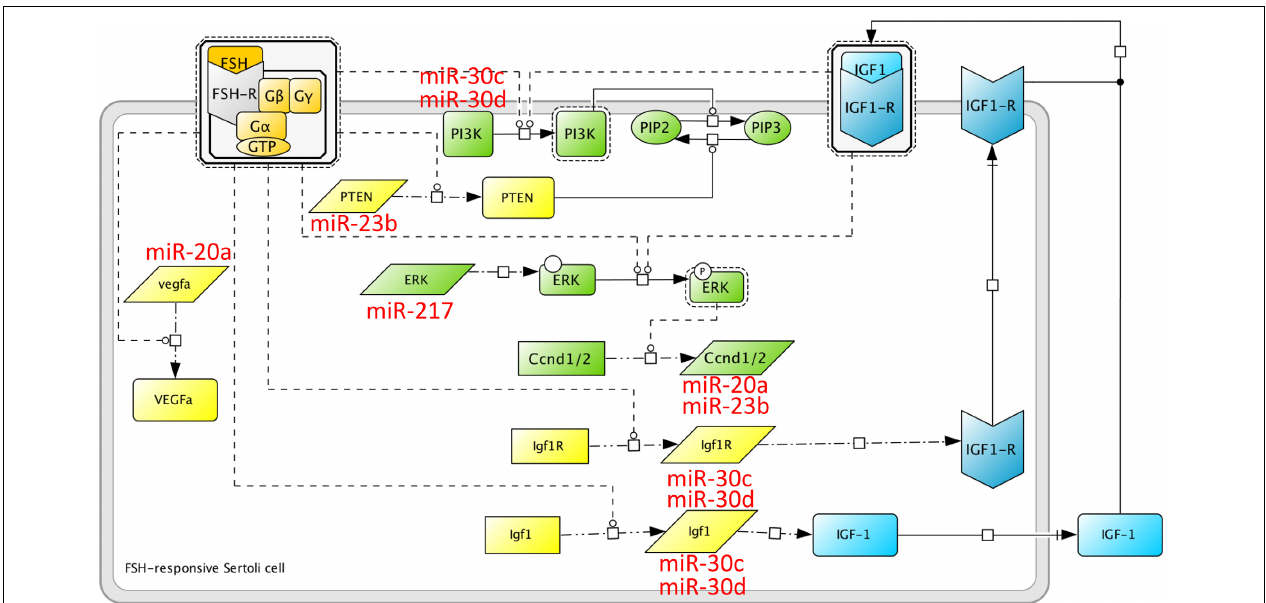
FIGURE 2 | MicroRNA induced by FSH at spermiogenesis. A microRNA network superimposes on the protein network induced by FSH. Here are shown some microRNAs whose expression is altered upon in vivo FSH suppression, i.e., miR-23b, miR-30c and miR-30d, mir-20a and miR-217, as reported in Nicholls et al. (2011). miR-30c and miR-30d target the IGF-1 system, as well as the PI3K pathway.